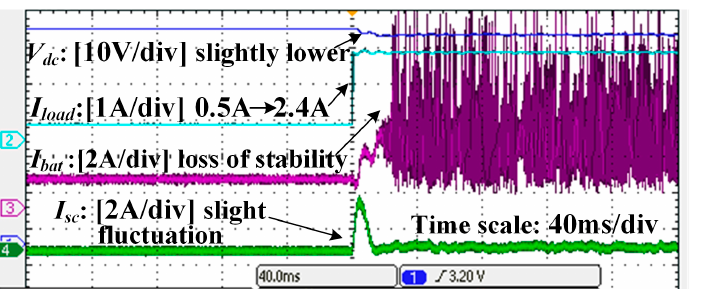
Figure 20. Control parameters of Group H: DC bus voltage, CPL current, battery current and SC current of a DC microgrid.